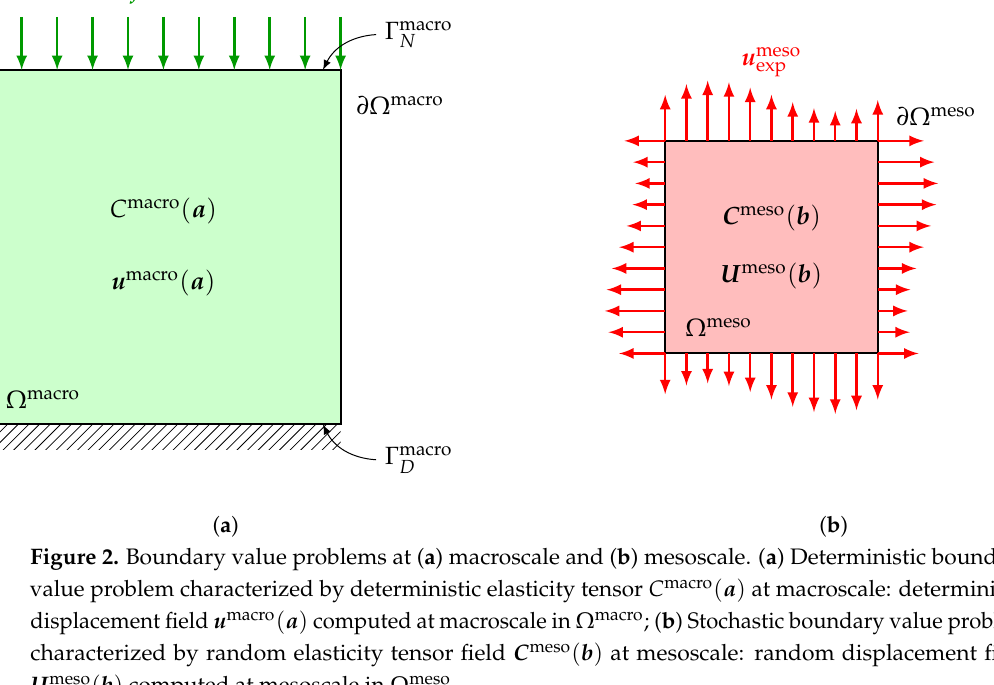
Figure 2. Boundary value problems at ( a ) macroscale and ( b ) mesoscale. ( a ) Deterministic boundary value problem characterized by deterministic elasticity tensor C macro ( a ) at macroscale: deterministic displacement field u macro ( a ) computed at macroscale in Ω macro ; ( b ) Stochastic boundary value problem characterized by random elasticity tensor field C meso ( b ) at mesoscale: random displacement field U meso ( b ) computed at mesoscale in Ω meso